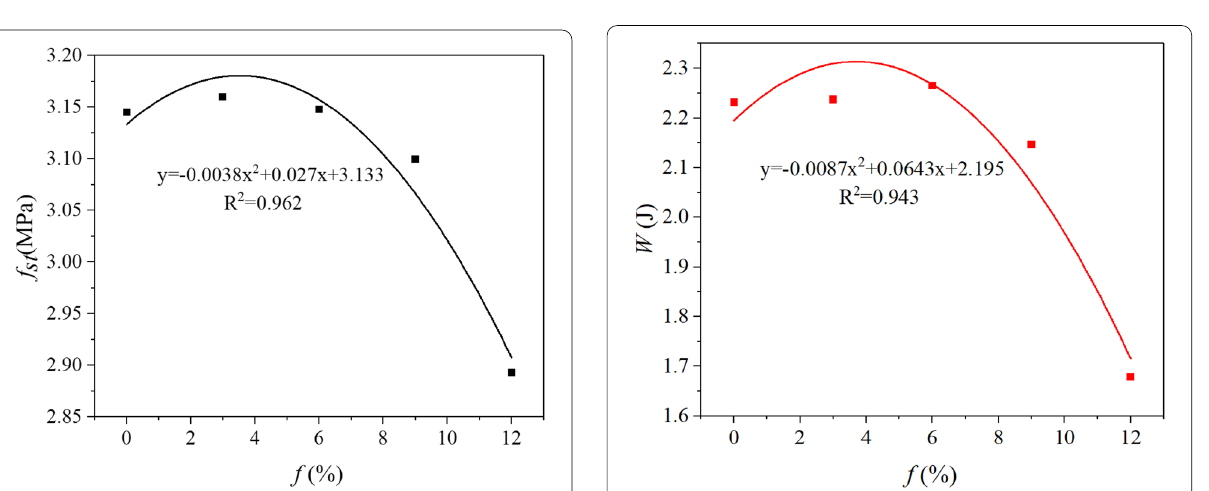
Fig. 22 Variation of dissipated fracture energy with silica fume content in interfacial